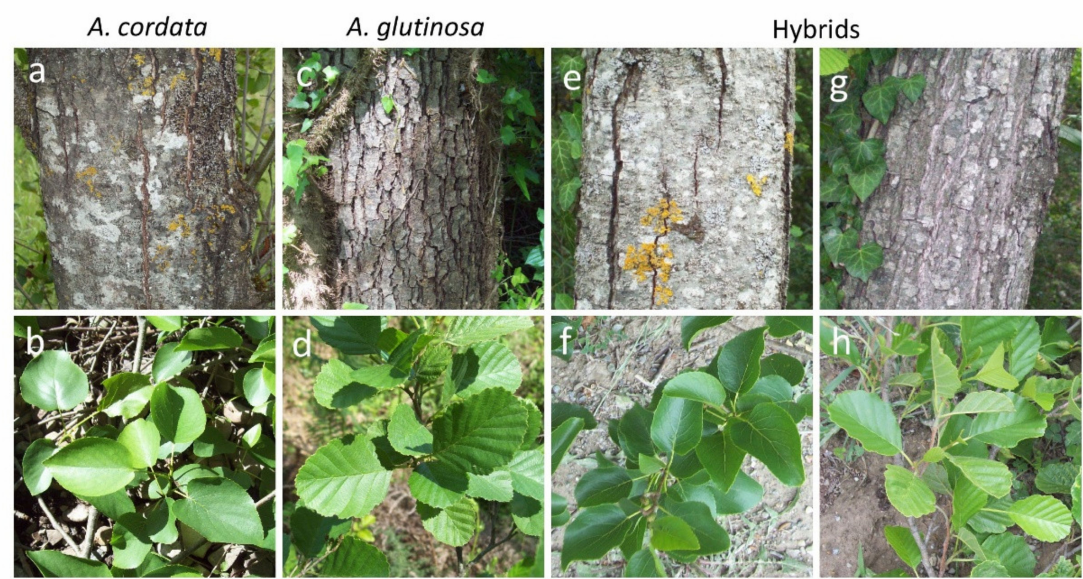
Figure 2. Examples of morphology of bark and leaves of Alnus trees sampled in this study. Taxonomic classification after NEWHYBRID genetic analysis: ( a , b ) A. cordata ; ( c , d ) A. glutinosa ; ( e – h ) interspecific